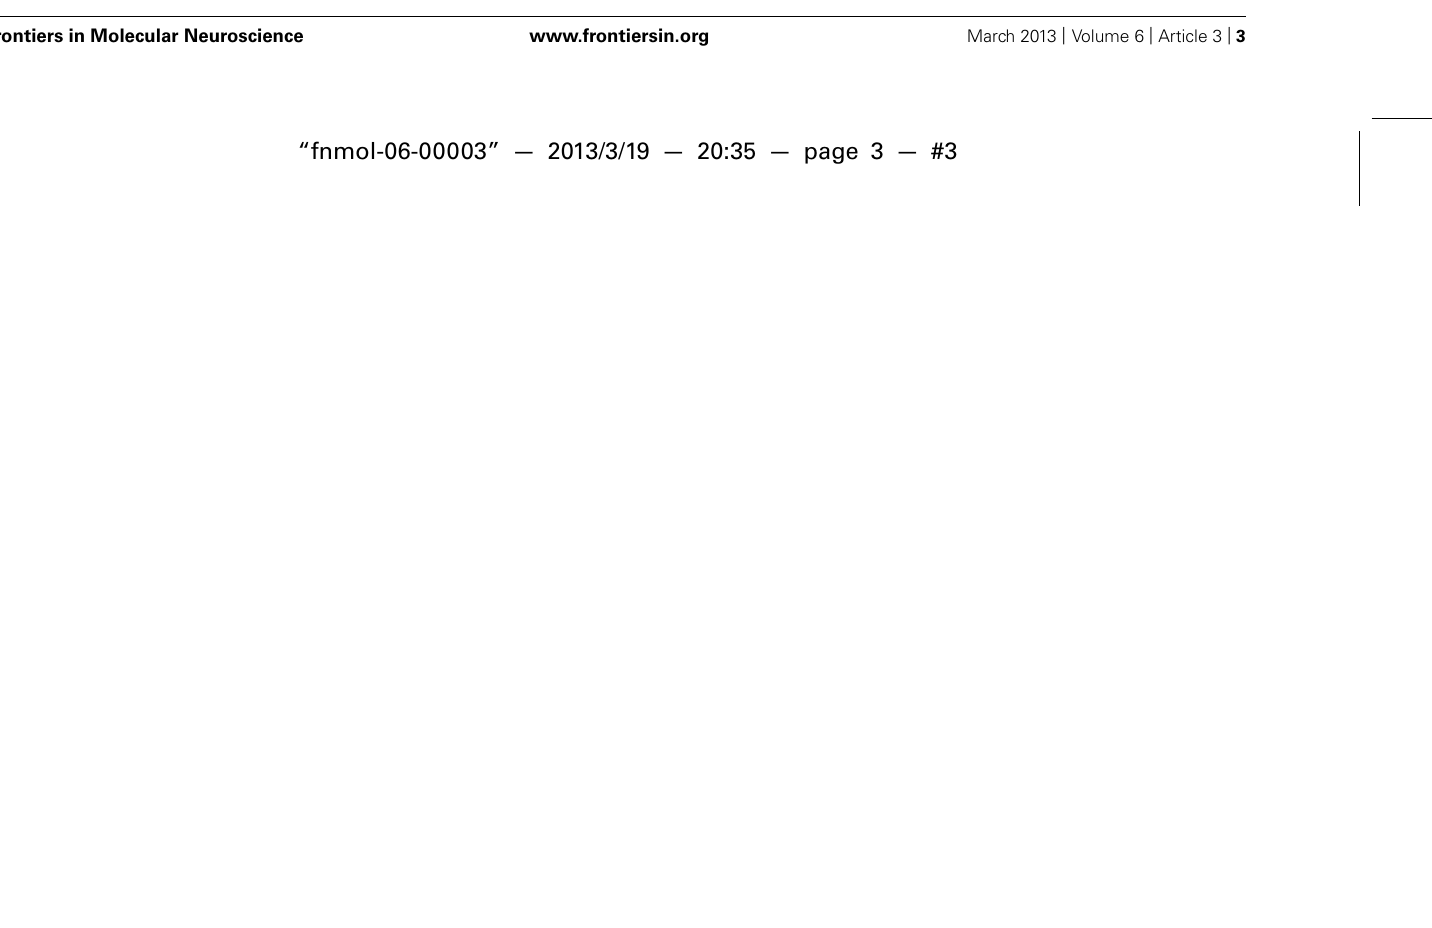
illuminated at 408 or 380 nm, respectively. The off, low and high rates of neurosecretion were reproducibly